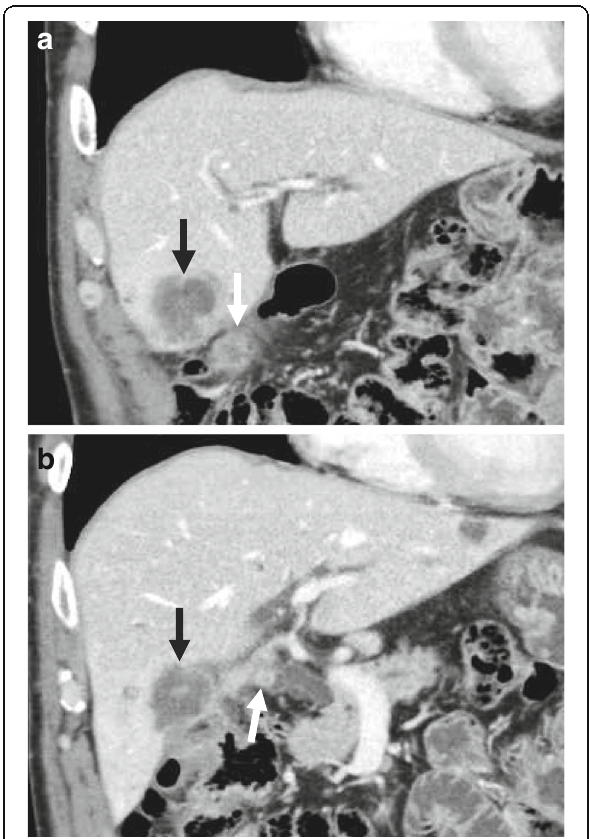
Fig. 1 Multidetector-row computed tomography (coronal section images). a A tumour with an ill-defined border ( black arrow ) was found in the medial segment (segment 4) 1 month after the initial cholecystectomy. There was a marginal contrast effect in the mass, so the possibility of a postoperative abscess or a carcinoma that had invaded the gallbladder was considered. A mass was also found on the ventral side of the transverse colon, and there was a possibility of peritoneal dissemination ( white arrow ). b In addition, another small mass was found at the stump of the cystic duct ( white arrow